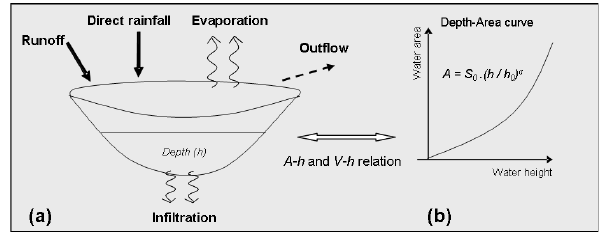
Fig. 2. Schematic representation of the hydrologic model. (a) Water balance model. (b) Area-depth